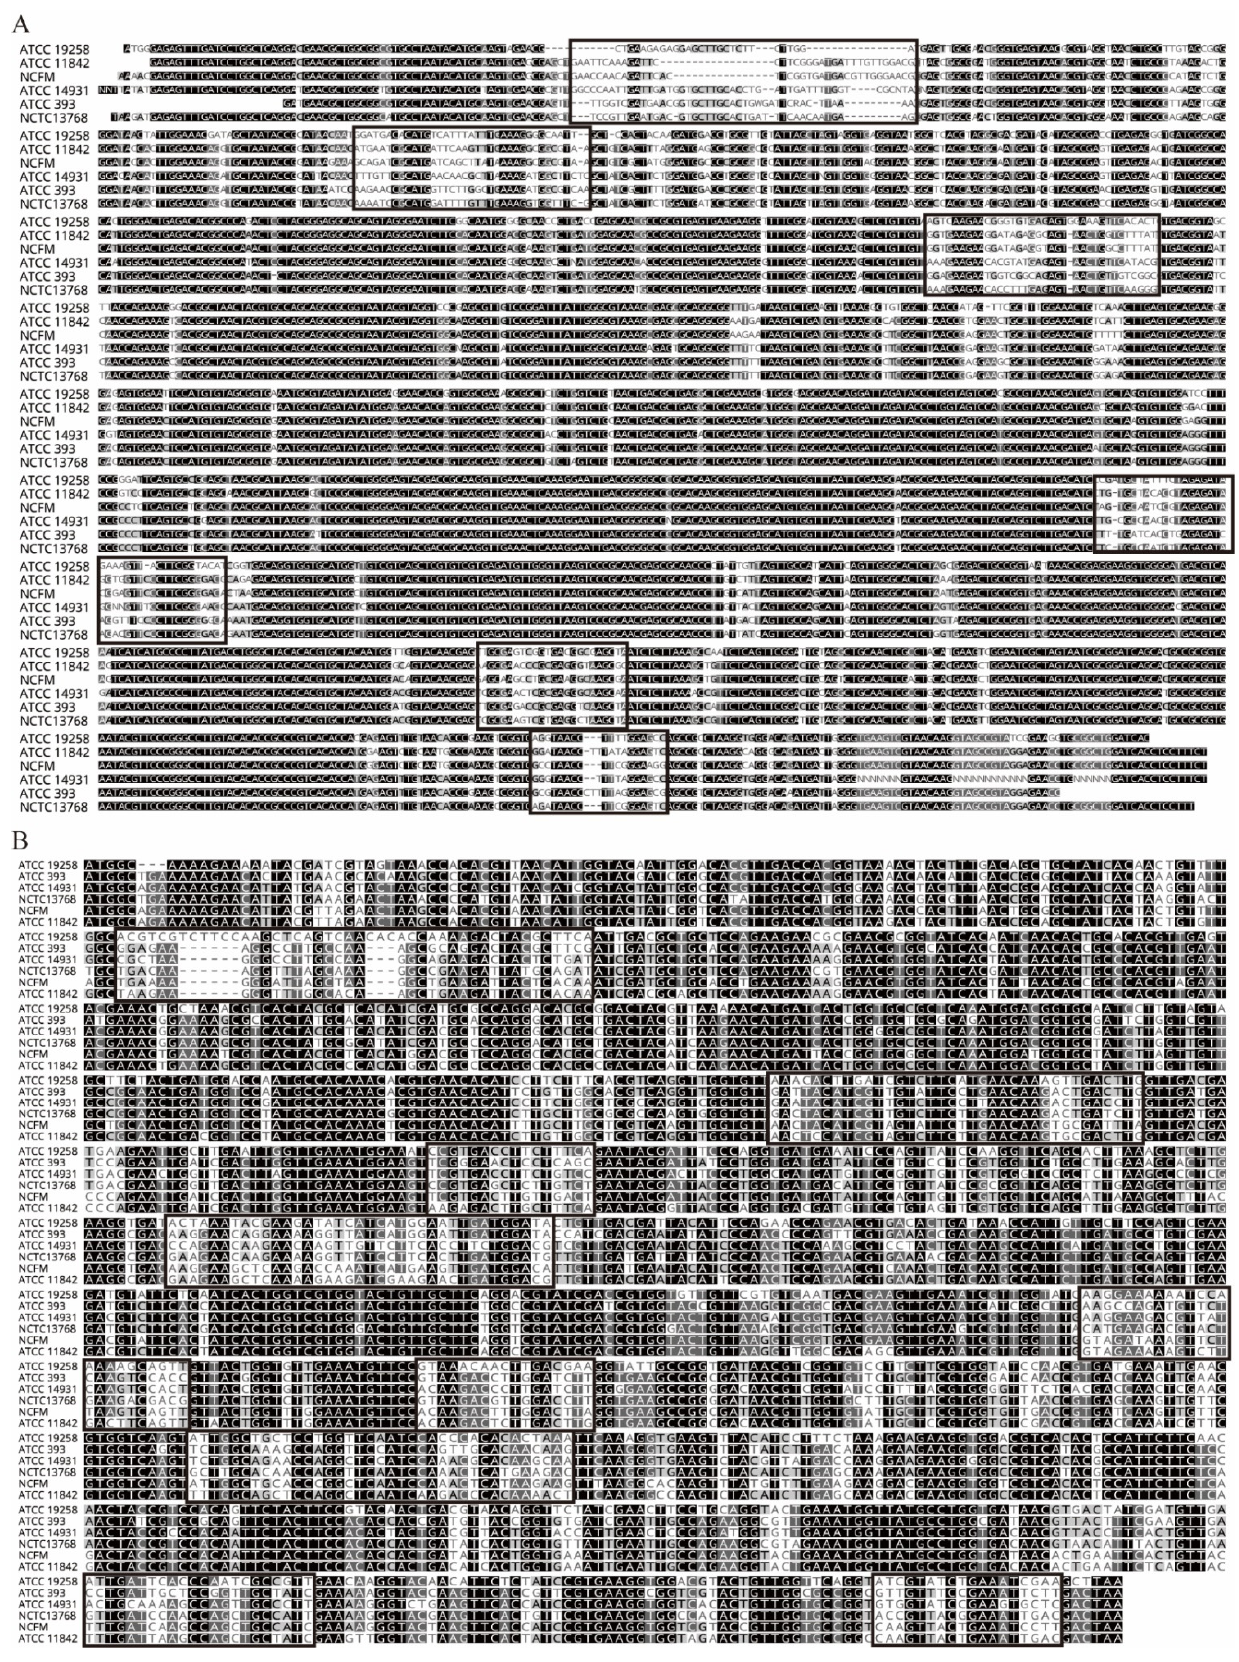
Figure 1. Multiple alignments of 16S rRNA and tuf genes of six lactic acid bacteria (LAB) model strains. ( A ): Multiplexed 16S rRNA gene comparison of six model strains of LAB; ( B ): multiple comparison of tuf gene of six model strains of LAB.